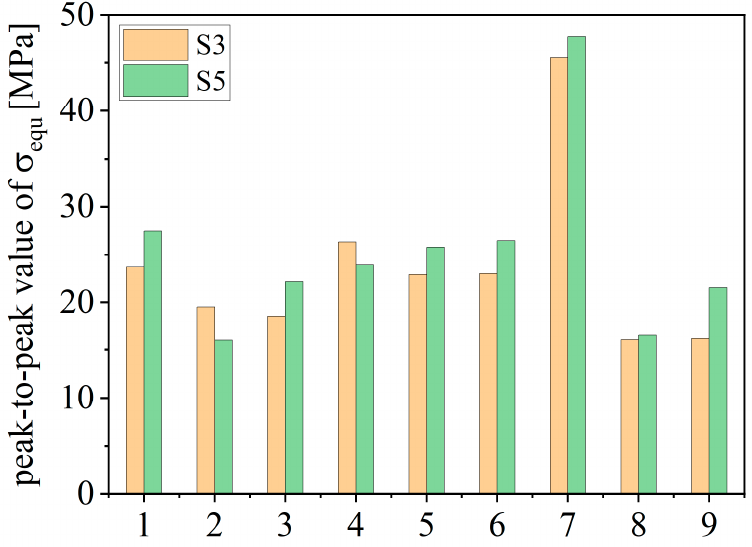
Figure 21. The peak ‐ to ‐ peak value of dynamic stress. Figure 21. The peak-to-peak value of dynamic